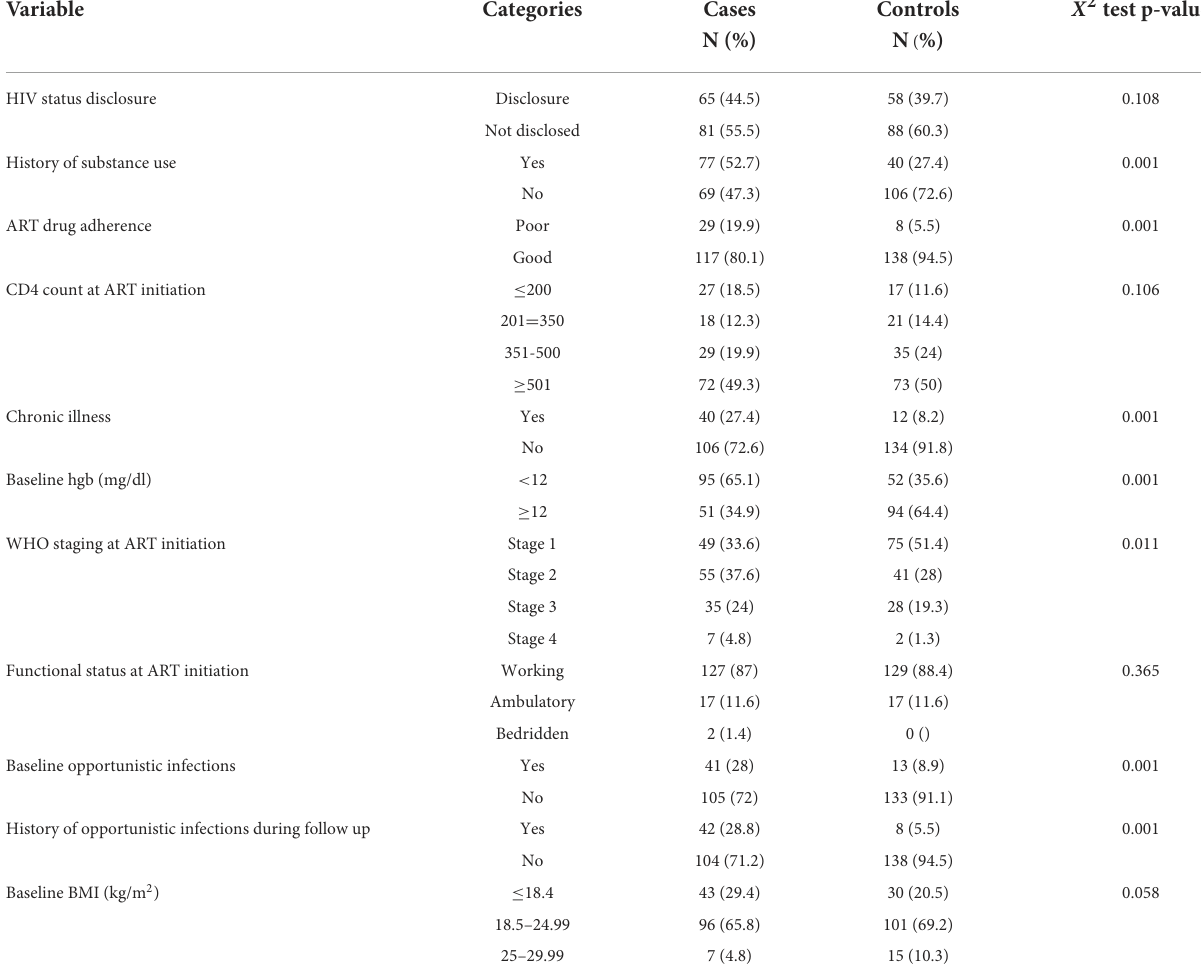
TABLE 2 The behavioral, clinical, and nutritional characteristics of patients with HIV treated at MTUTH in 2020.